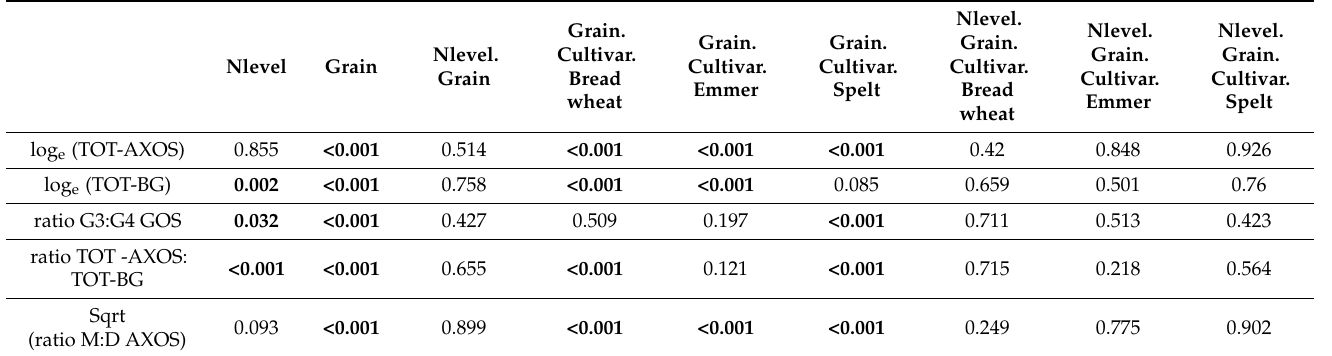
Table 4. p -values from ANOVA of the proportions of AXOS and GOS in the three cereal types and cultivars.